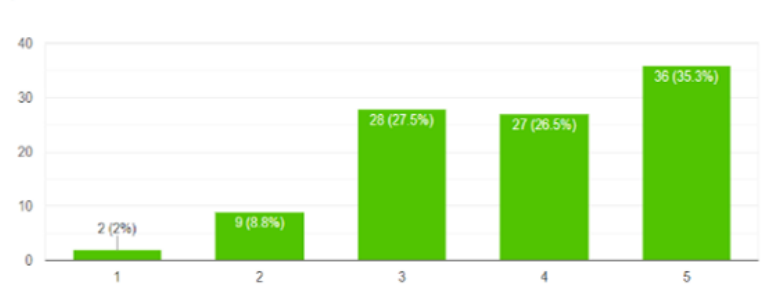
Figure 4: Municipal taxes for the question related to tax payment to build better places in karachi